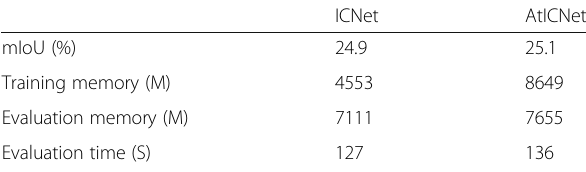
Table 2 Without loading the pre-training model, our model mIoU is slightly higher than ICNet